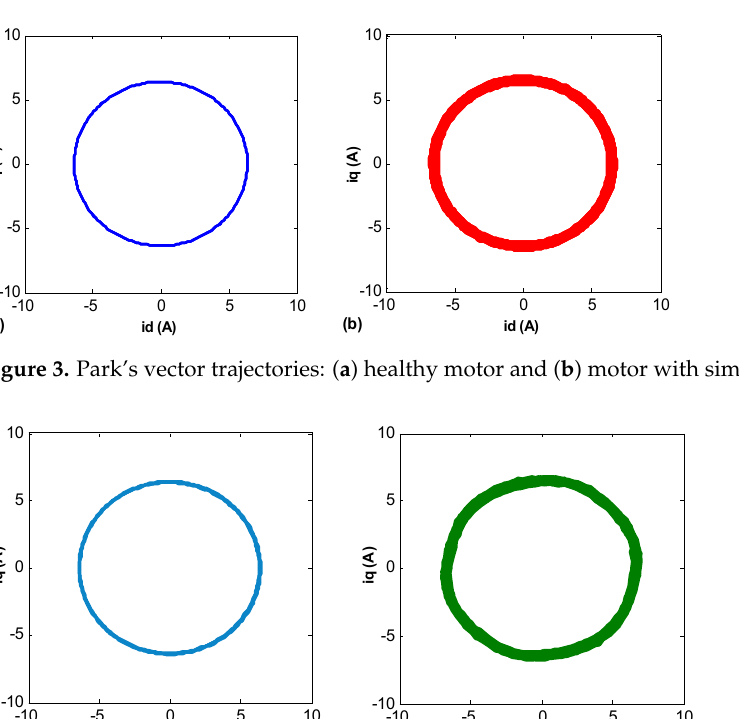
Figure 2. Proposed flow chart of the CPEPVA.